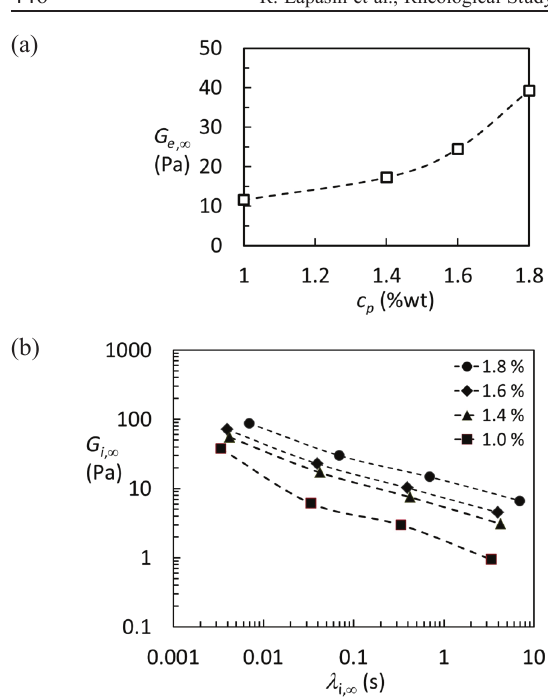
Fig. 10 – Concentration dependence of gM parameters in the final asymptotic condition (for t → ∞). a) Equilibrium mod - ulus G b) time relaxation spectra G e